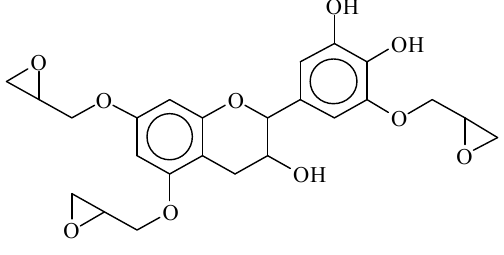
Scheme 3. Most probable structure of the 476 Da MALDI peak.